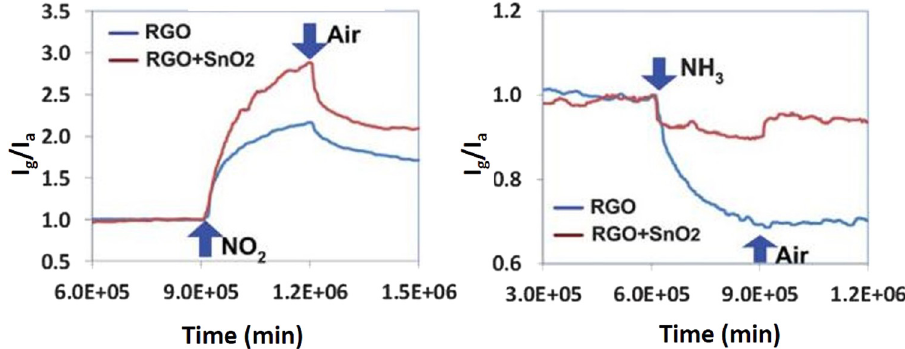
Figure 24: Gas sensing signals of NO 2 and NH 3 from pristine rGO sensors ( blue line ) and SnO 2 nanocomposites ( red line ) . Reproduced from ref. [ 125 ] .